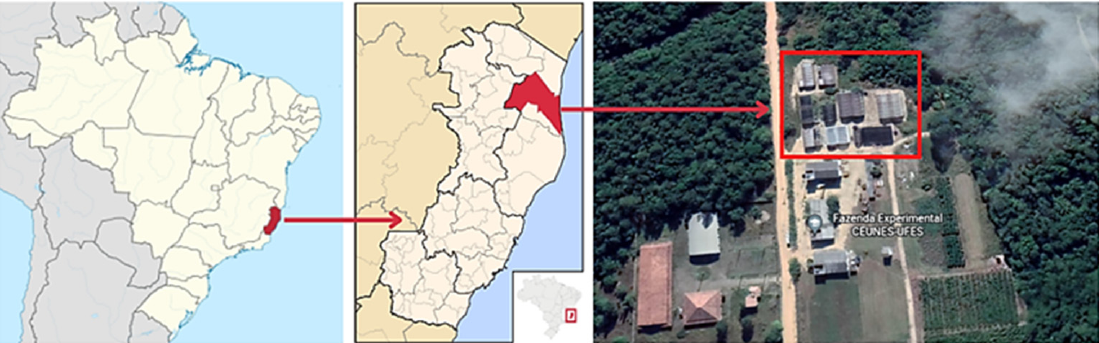
Figure 6. The test location and a brief overview of the acclimatization greenhouse marked with red rectangles.